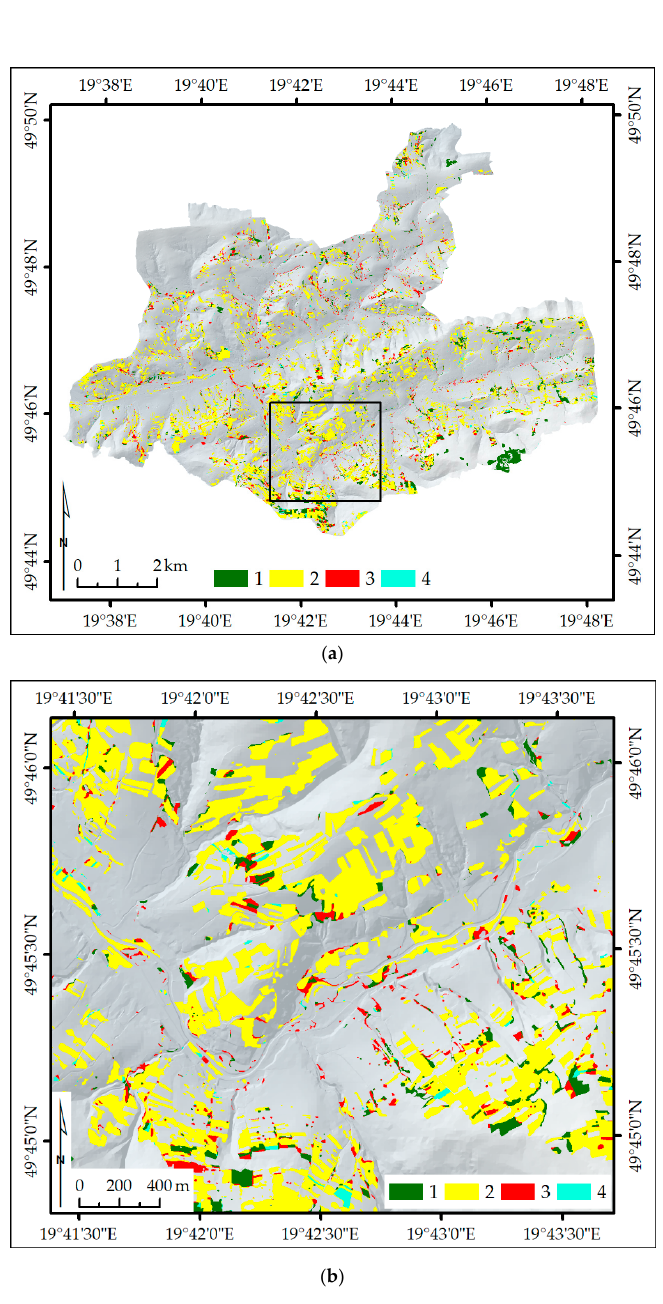
Figure 4. Results of old and new succession classification: ( a ) the entire study area, the black polygon indicates zoom area shown in ( b ); 1—new succession classified incorrectly, 2—new succession classified correctly, 3—old succession classified incorrectly, and 4—old succession classified correctly.